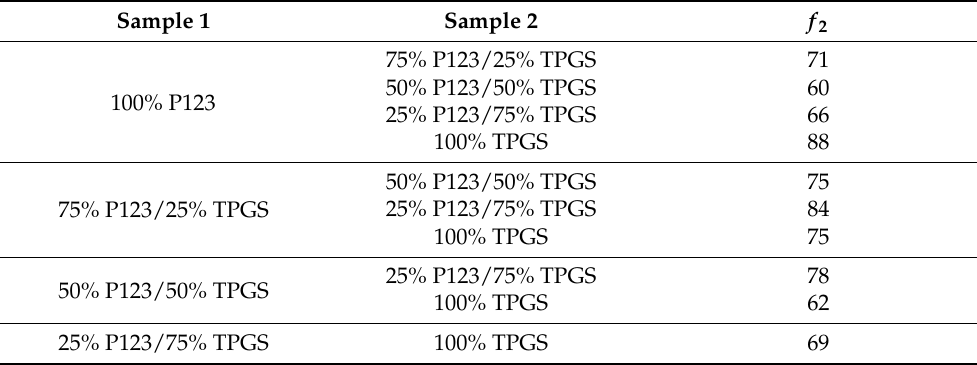
Figure 7. In vitro release of R19 from R19-loaded NPs in PBS pH 7.4 at 37 °C, demonstrating sustained drug release up to 96 h. Results are expressed as the mean cumulative release % ± SD ( n = 3) plotted against time (h). Table 3. Similarity factor ( f 2 ) results for R19-loaded NPs.